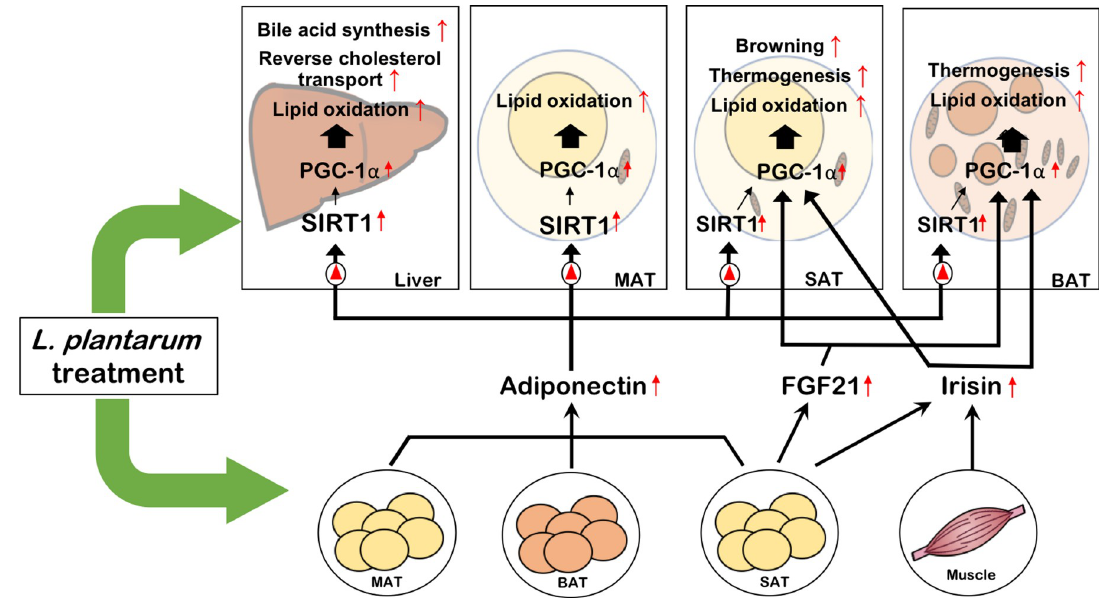
Fig 6. A summary on the protective effects of L . plantarum probiotics against high-fat diet-induced metabolic dysfunctions through activation of the PGC-1 α pathway.